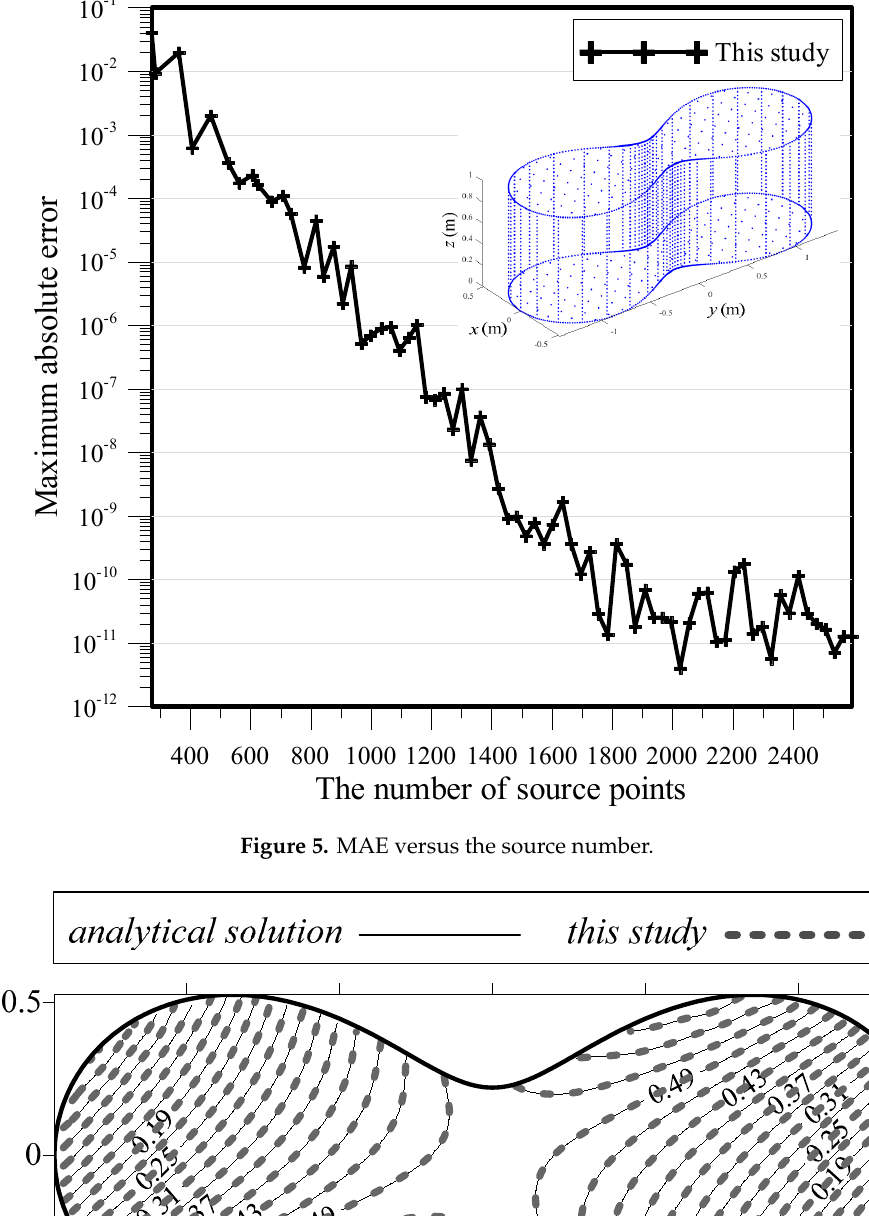
Figure 4. Maximum absolute error (MAE) versus the order of η .